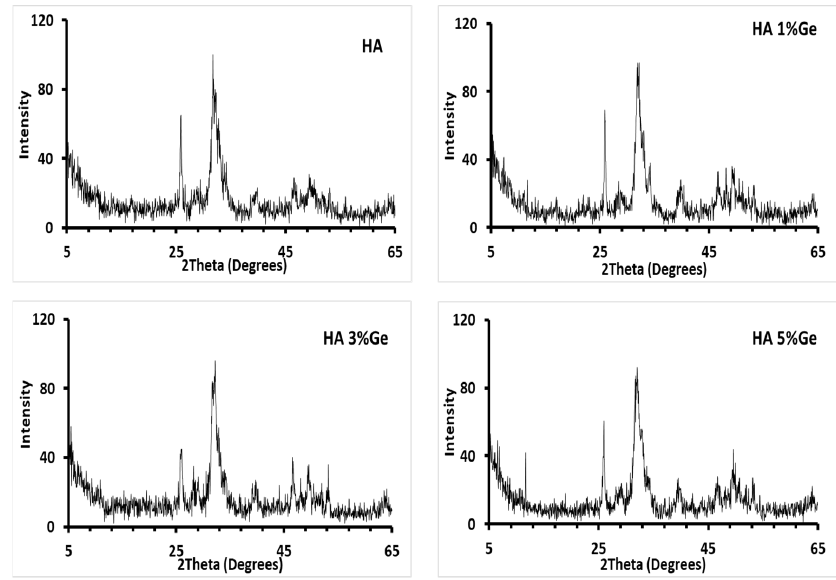
Figure 2. X-ray diffraction patterns of the composites HA-Ge biomaterials. HA-control, HA 1% Ge: HA with 1% germanium, HA 3% Ge: HA with 3% germanium, and HA 5% Ge: HA with 5% germanium.